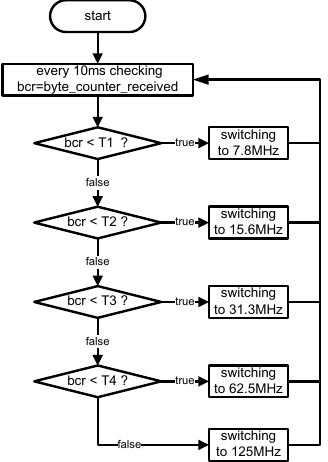
Figure 5. Flowchart of the single-threshold